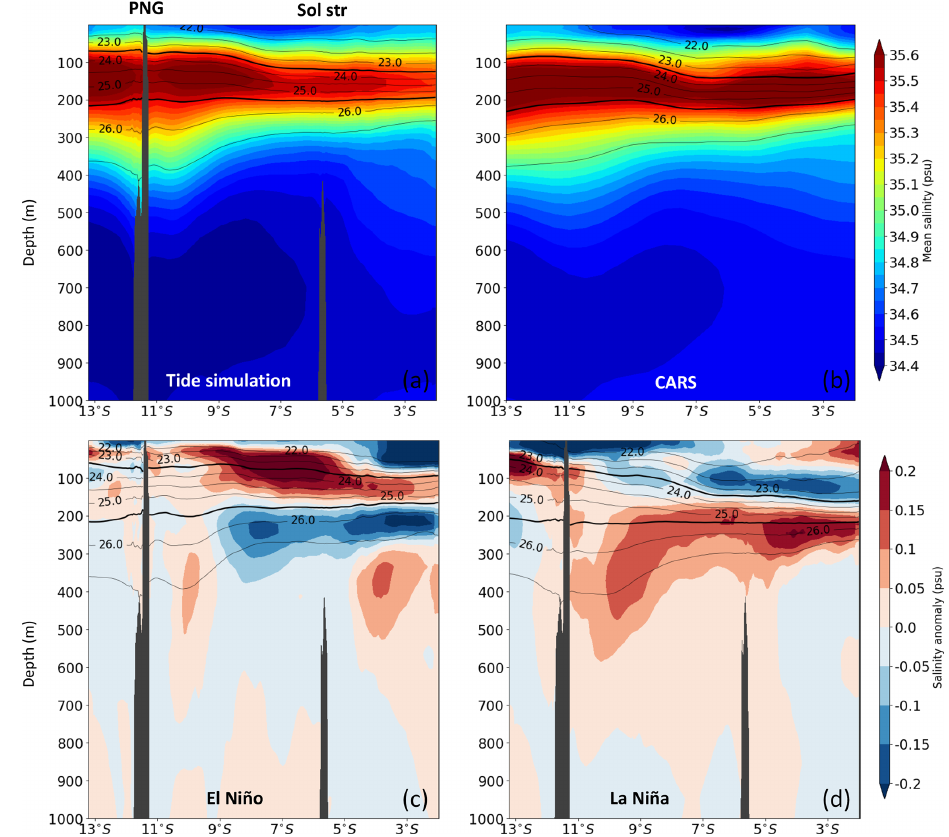
Figure 4. Latitude/depth section at 154 ◦ E of mean salinity (a) from the R36Td simulation, (b) from CARS climatology, and of salinity anomalies for the 3-month (c) El Niño period and (d) La Niña period, relative to the full R36Td period. The Solomon Sea section is between the topographic features (vertical black lines) at 12 and 6 ◦ S. The black contours highlight the upper thermocline layer